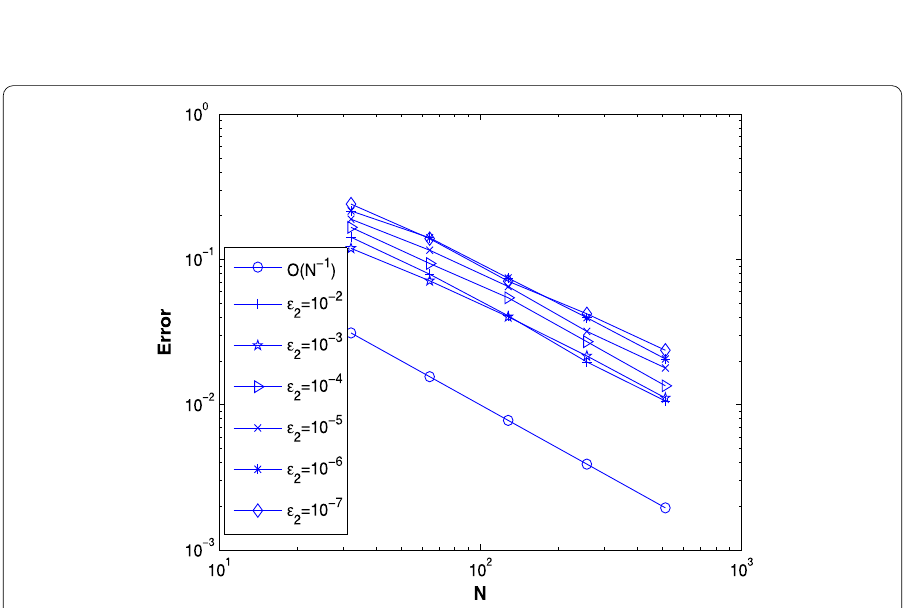
Figure 4 Loglog plot of the maximum error of the solution for Example 5.1 with ε 1 = 10 –2